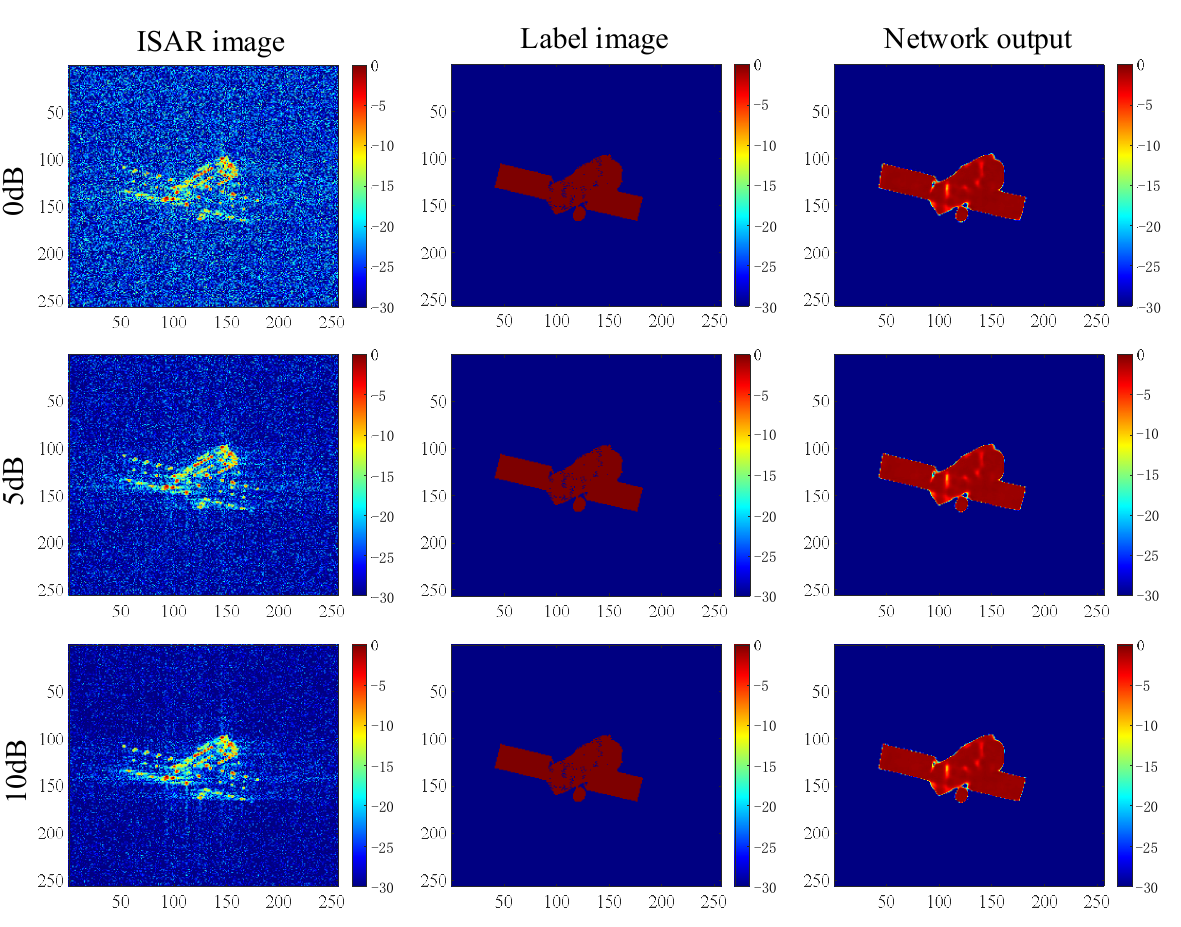
Figure 13. The imaging results of test data 4 under different SNRs. Table 9. The Euler angle estimation results of test data